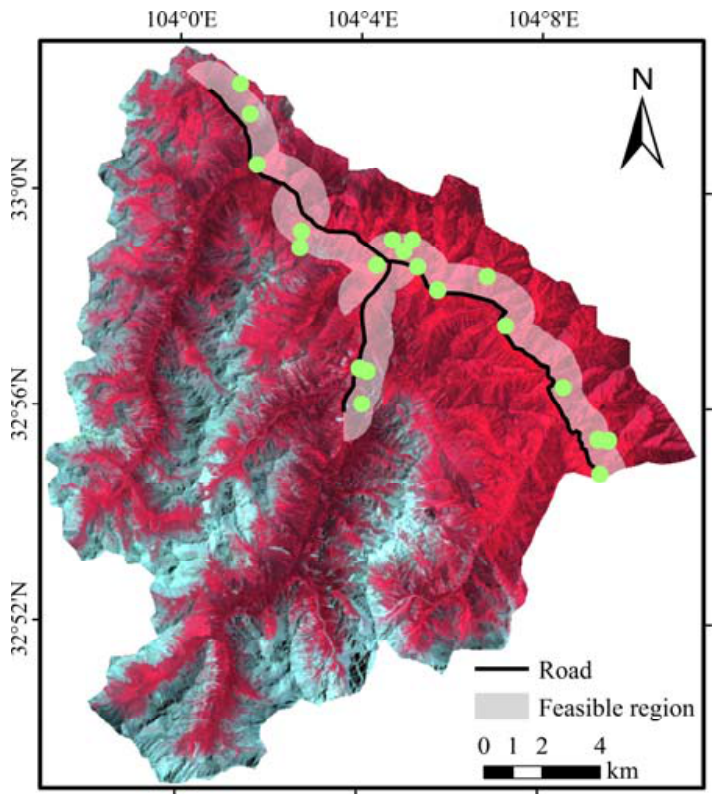
Figure 3. The spatial distribution of the 20 elementary sampling units for the multi-temporal constrained sampling design in the feasible region.